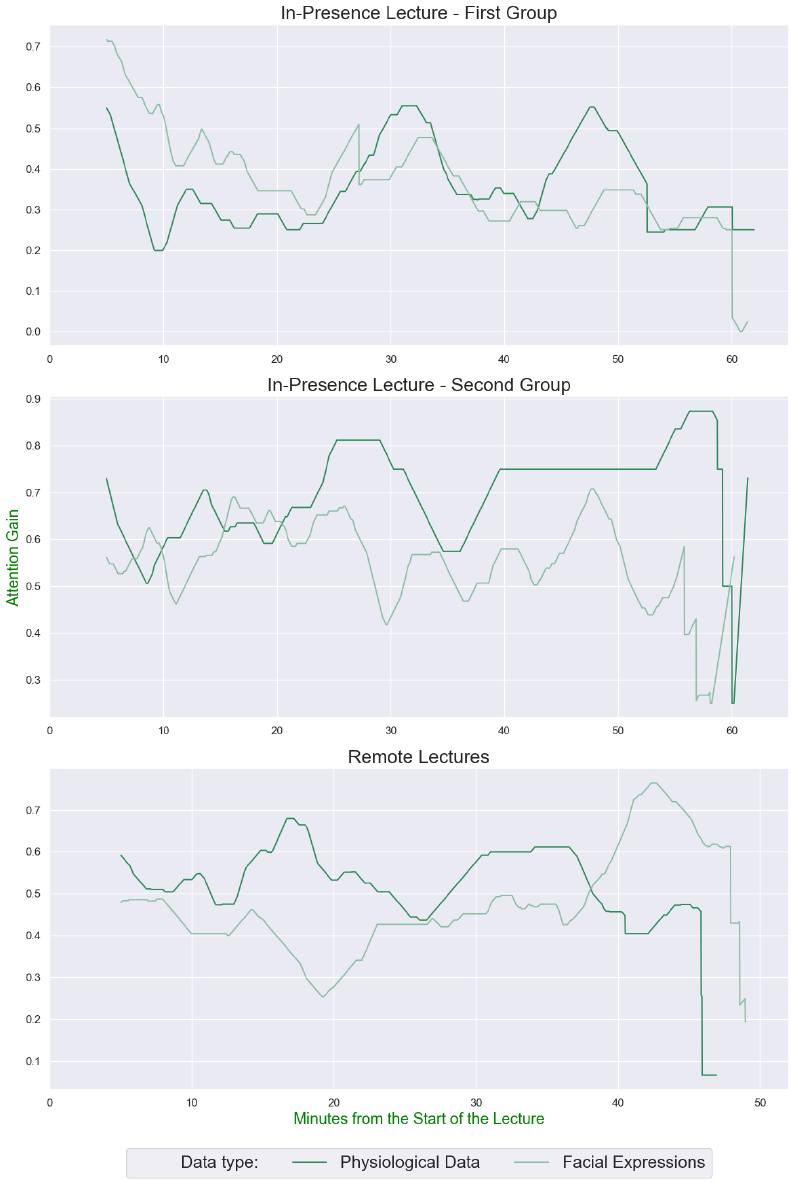
Figure 4. ABs of the in-presence and remote lectures obtained from AA p and AA fe with a WS of 100 samples and applying the 5 min attention counters every